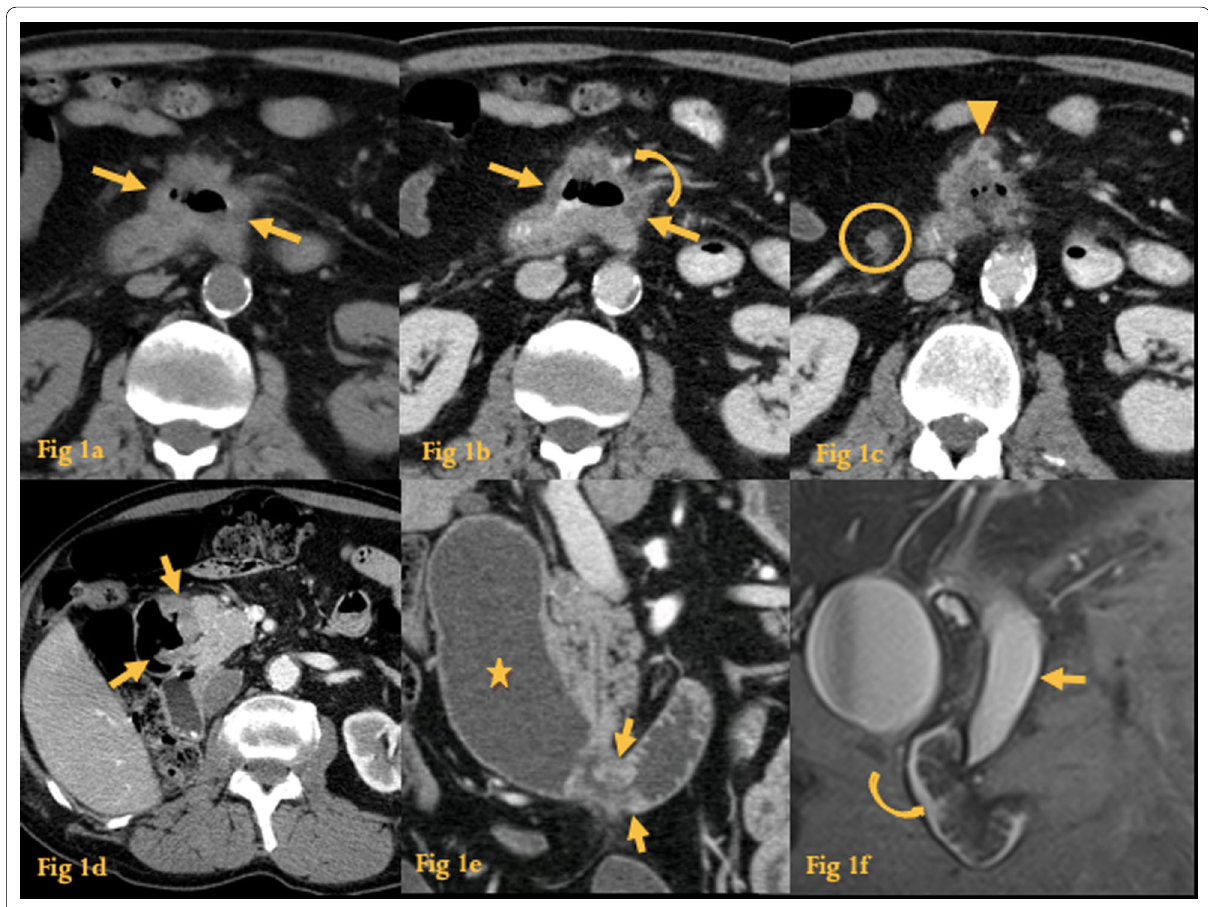
Fig. 1 Adenocarcinoma. Abdominal CT performed before ( a ) and after ( b , c ) iv contrast administration shows irregular circumferential asymmetric thickening of D3, causing deformity of the lumen (arrows). There is encasement of the superior mesenteric artery (curved arrow) and tumor thrombosis of the superior mesenteric vein (arrowhead), rendering the lesion surgically unresectable. There is also periduodenal fat stranding and adenopathy (circle). Abdominal CT ( d ) of another case of duodenal carcinoma with an ulcerated mass at D2 (arrows). Abdominal CT of yet another case of duodenal carcinoma ( e ); there is circumferential duodenal thickening (arrows) which caused luminal stenosis with proximal dilatation (asterisk). MRCP of another patient ( f ) showing a polypoid duodenal lesion (curved arrow) that caused CBD dilatation (arrow), which proved to be a duodenal